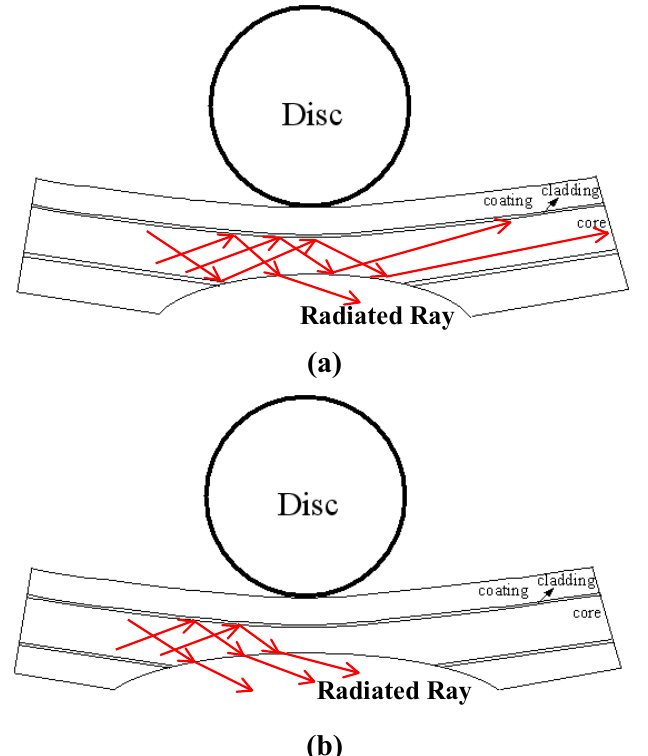
Figure 7. Ray paths in deformed POF specimens at various groove depths. ( a ) h = 0.9 mm. ( b ) h = 1.1